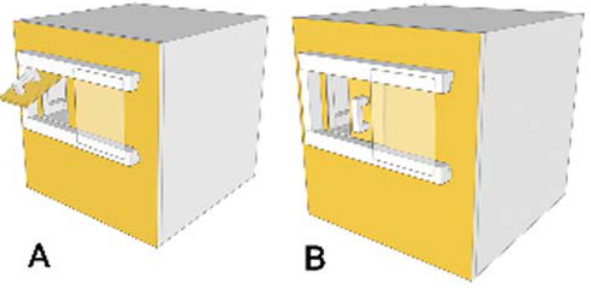
Figure 1. Foraging apparatus. The ‘Doorian Fruit’ presented two distinct methods for extracting food from the apparatus. The same door could either be lifted (a) or slid (b) open in order to reveal a food tray.